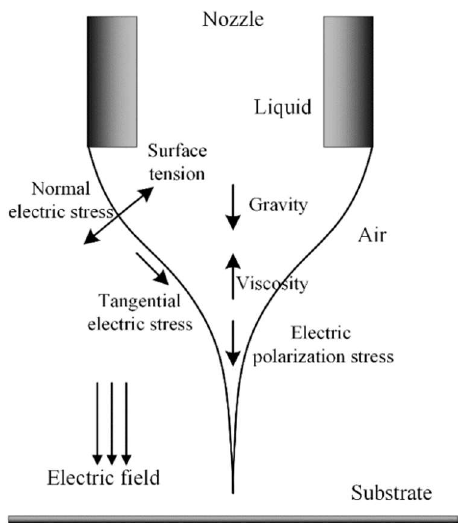
Figure 1. Distribution of active forces on the liquid cone-jet.